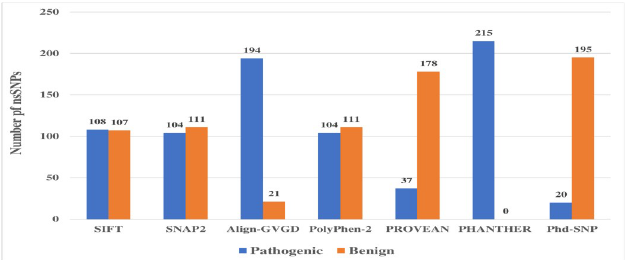
Fig 2. Prediction of pathogenicity of nsSNPs by SIFT, SNAP2, Align- GVGD, PolyPhen-2, PROVEAN, PANTHER and PhD-SNP software.